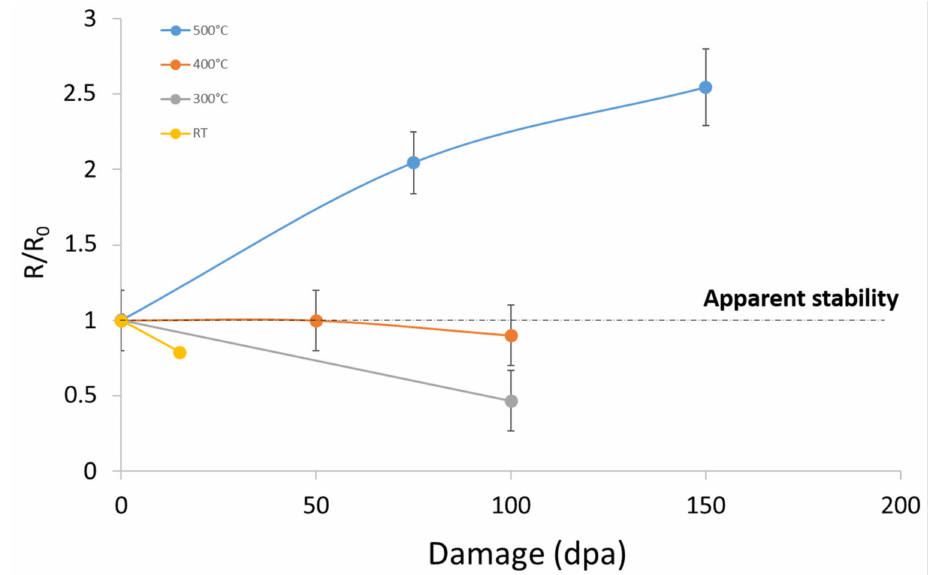
Figure 14. Evolution of the nano-oxides’ normalized radii after irradiation at RT, 300 ◦ C, 400 ◦ C and 500 ◦